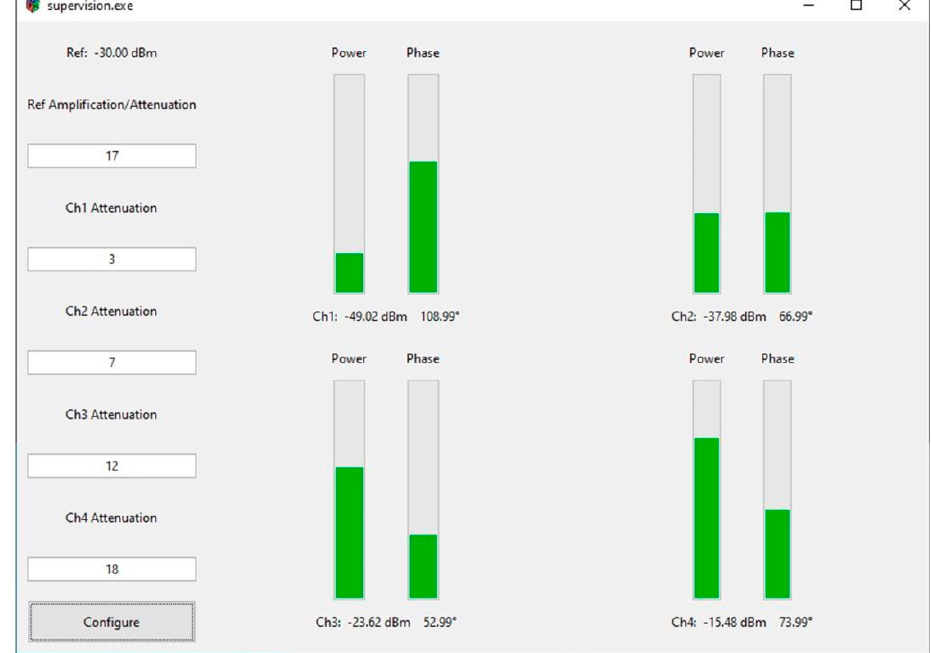
Figure 2. Graphical user interface (GUI). Users can configure the conditioning chips on the left side of the GUI. The RF power and phase information are displayed on the right of the GUI. Progress bars are used to show the relative relationship between channels.